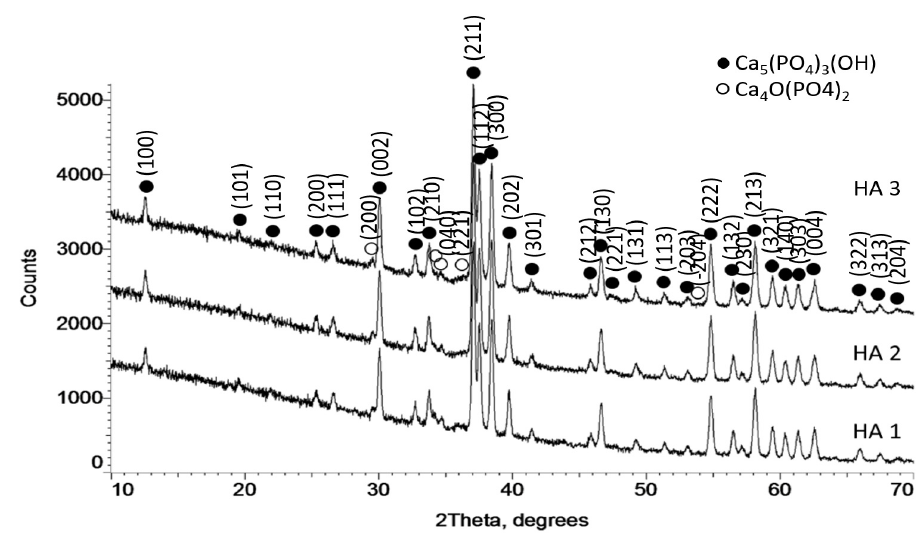
Figure 6. XRD patterns of hydroxyapatite (HA) coatings (HA1, HA2, and HA3).